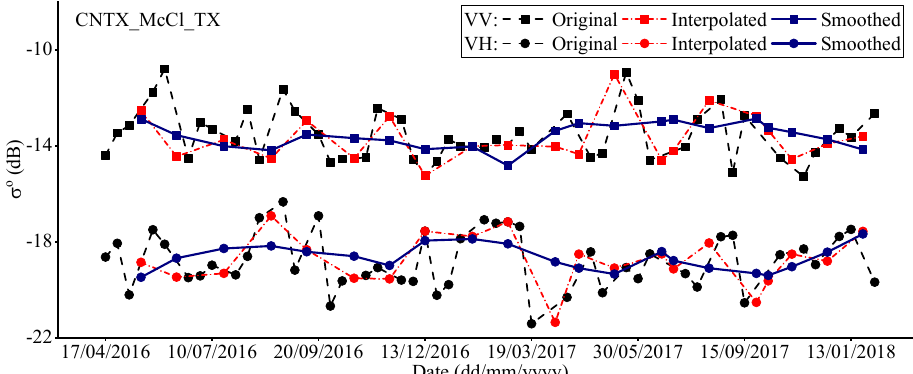
Figure 4. The times-series Sentinel-1A data in its original, interpolated and smoothed versions.